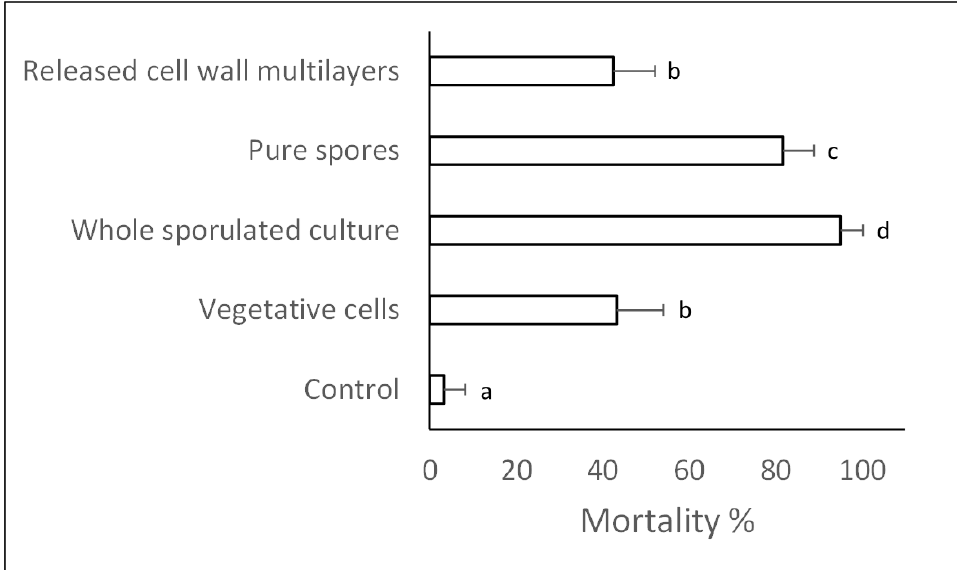
Figure 4. Mortality (mean ± SD) of house flies treated with different bacterial preparations at the normalized concentration of 10 9 cells/spores per mL. Different letters beside the bars indicate significantly different means (ANOVA, followed by least significant difference (LSD) test, p < 0.001).